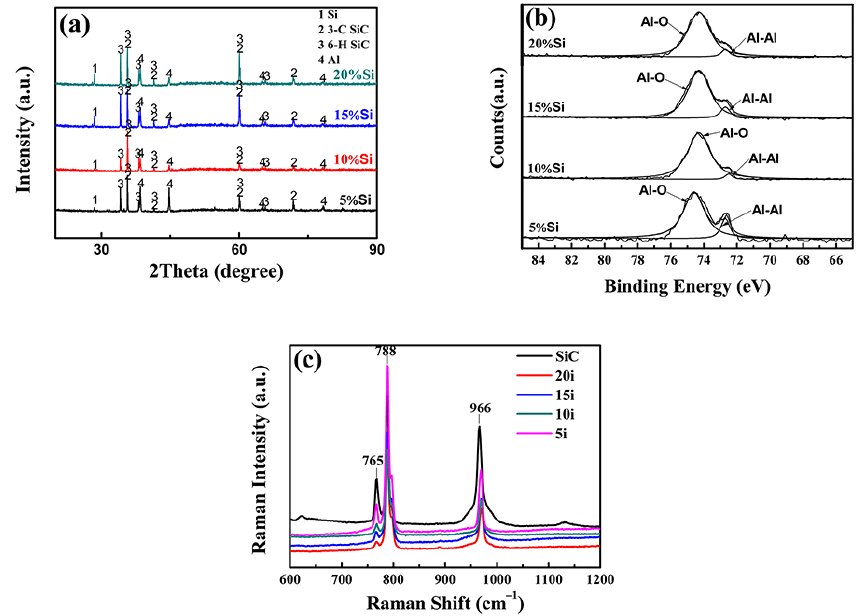
Figure 5. XRD patterns ( a ), X-ray photoelectron spectroscopy (XPS) spectra ( b ) and Raman spectra ( c ) of the composites. Table 3. Volume fraction (vol.%) of central phase.